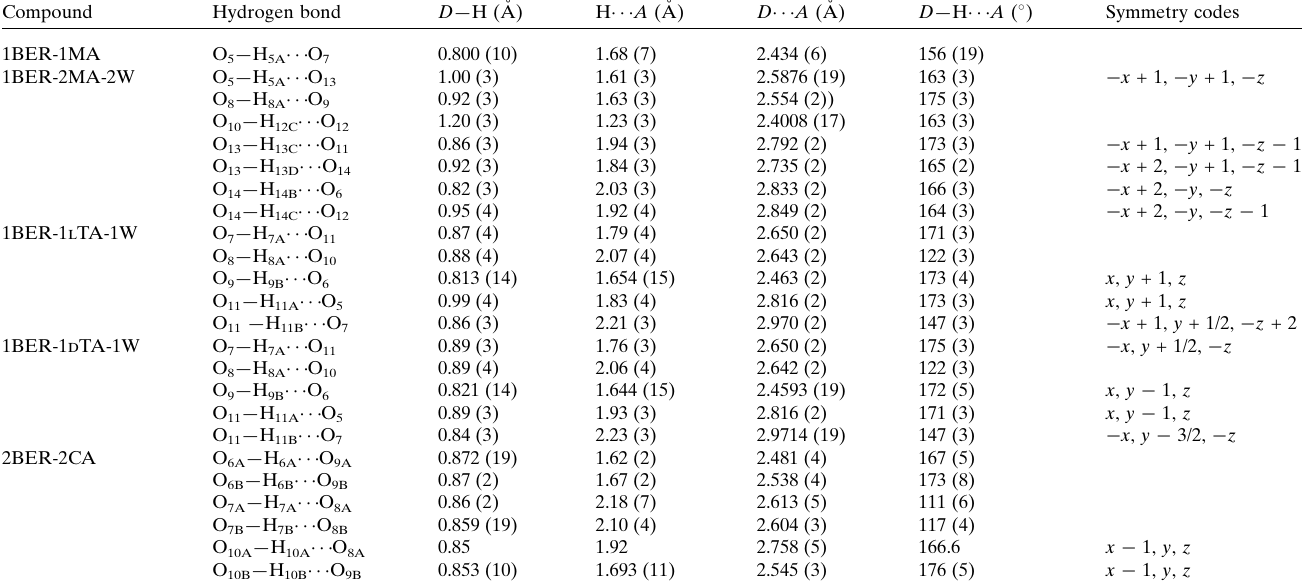
Table 2 Hydrogen-bond geometry of the BER solid forms obtained.